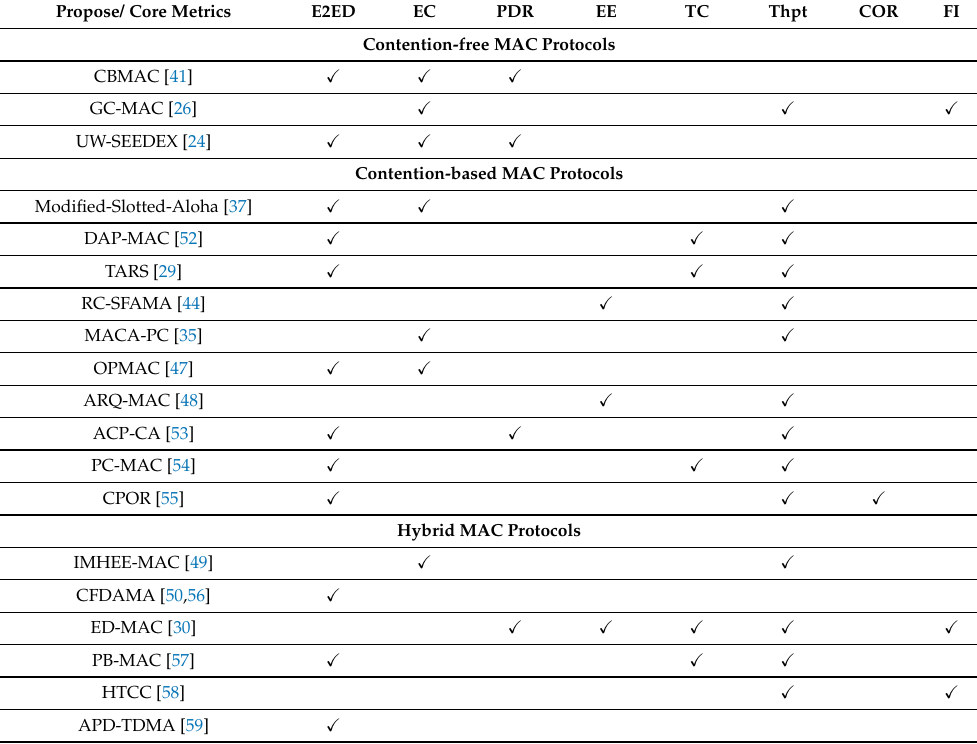
Table 4. Summary of the Common Performance Metrics of UWSN MAC